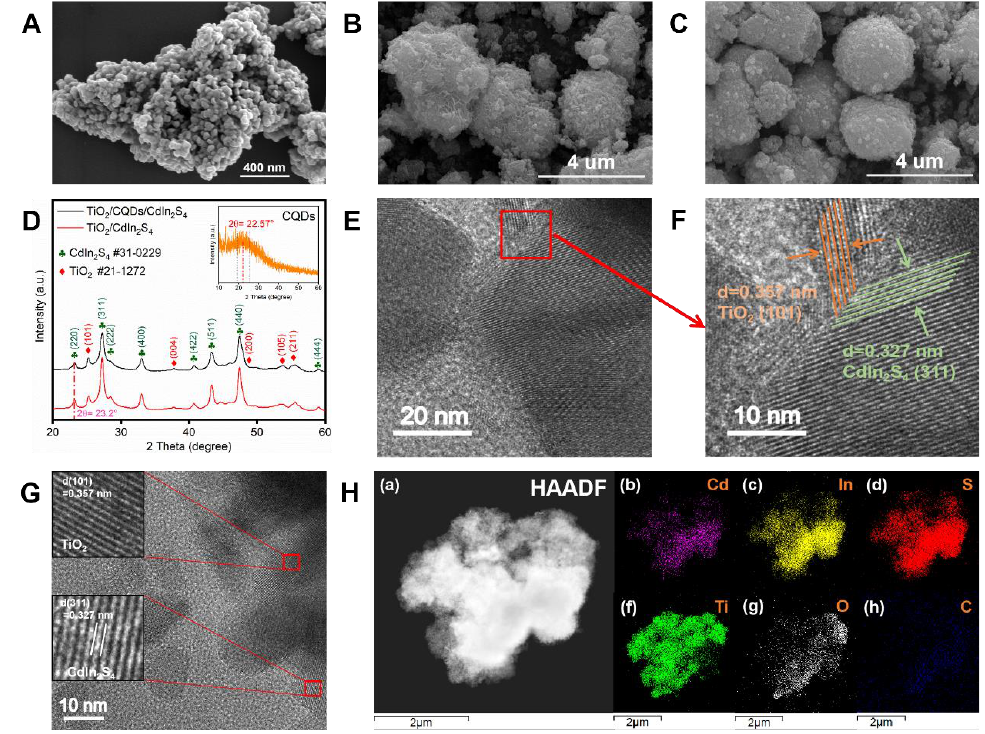
Figure 1. SEM images of ( A ) as-prepared TiO 2 ; ( B ) TiO 2 /CdIn 2 S 4 ; ( C ) TiO 2 /CQDs/CdIn 2 S 4 ; ( D ) PXRD patterns of TiO 2 /CdIn 2 S 4 and TiO 2 /CQDs/CdIn 2 S 4 ; ( E – G ) TEM images of TiO 2 /CQDs/CdIn 2 S 4 at different magnifications and locations; ( H ) TEM-EDS elemental mapping of TiO 2 /CQDs/CdIn 2 S 4 . To confirm the phase and crystal structures of the as-prepared samples, powder X- ray diffraction (PXRD) (Figures 1D and S1) analysis was performed. On the one hand, the main diffraction peaks located at 2θ = 23.15°, 27.24°, 33.00°, 40.73°, 43.31° and 47.41° can be indexed to cubic crystal structure of CdIn 2 S 4 (JCPDS#27-0060), corresponding to the indices of (220), (311), (400), (422), (511) and (440) planes, respectively [49,50]. On the other hand, the diffraction peaks in TiO 2 /CQDs/CdIn 2 S 4 composite exhibit a standard phase of tetragonal TiO 2 (JCPDS#21-1272) with the lattice (101), (004), (200), (105) and (211) [30]. In addition, CQDs (top right ) showed a broad peak centered at 2θ = 22.57° with low intensity owing to the small size, which is consistent with the previous reports [48,51 – 53]. Thus, the (220) plane of CdIn 2 S 4 at 2θ = 23.2° in TiO 2 /CQDs/CdIn 2 S 4 did not alter significantly com- pared with TiO 2 /CdIn 2 S 4 due to the low intensity of CQDs characteristic peak. The crystal size of CQDs is evaluated based on the PXRD patterns using Debye – Scherrer equation [53 – 56], which is capable of calculating the size of nanocrystals based on the X-ray diffrac- tion features, regardless of the aggregation of these nanocrystals. Meanwhile, the full width at half maximum (FWHM) of as-prepared CQDs is measured to be 546.01×10 −4 rad, suggesting an ultra-small size of ca. 2.5615 nm (Table 1), confirming that the synthesized samples were quantum dots with the unique property of quantum dots, whose size ranges from 1 to 10 nm. As seen in Figure 1D, in comparison to TiO 2 /CdIn 2 S 4 , TiO 2 /CQDs/CdIn 2 S 4 presents no significant change, which is ascribed to the weak XRD signal of CQDs. Table 1. The crystal sizes of the photocatalysts and CQDs calculated by Debye – Scherrer equation. Sample